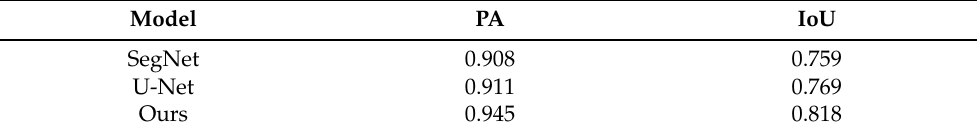
Table 4. Results of different models.